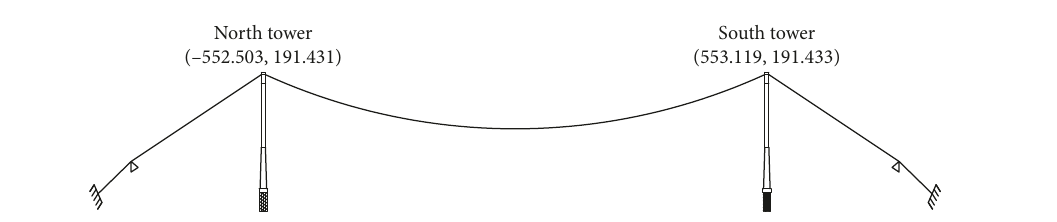
Figure 2: Main cable system of Huangpu Suspension Bridge (unit: m). Table 2: Comparison of length adjustment results for datum strand in midspan with different sag-span ratios.